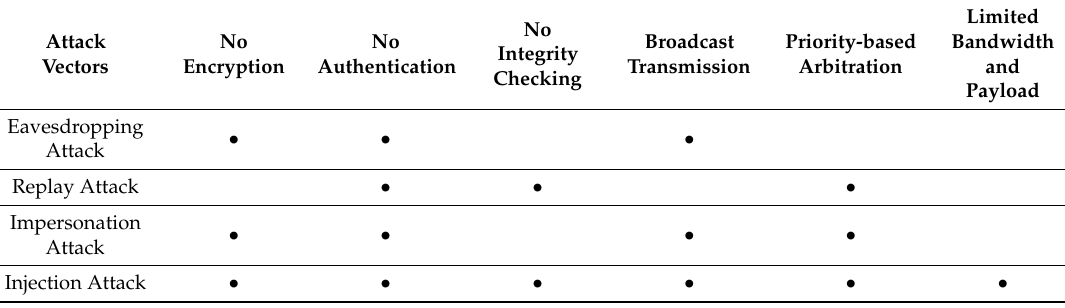
Table 1. Mapping between vulnerabilities and attack